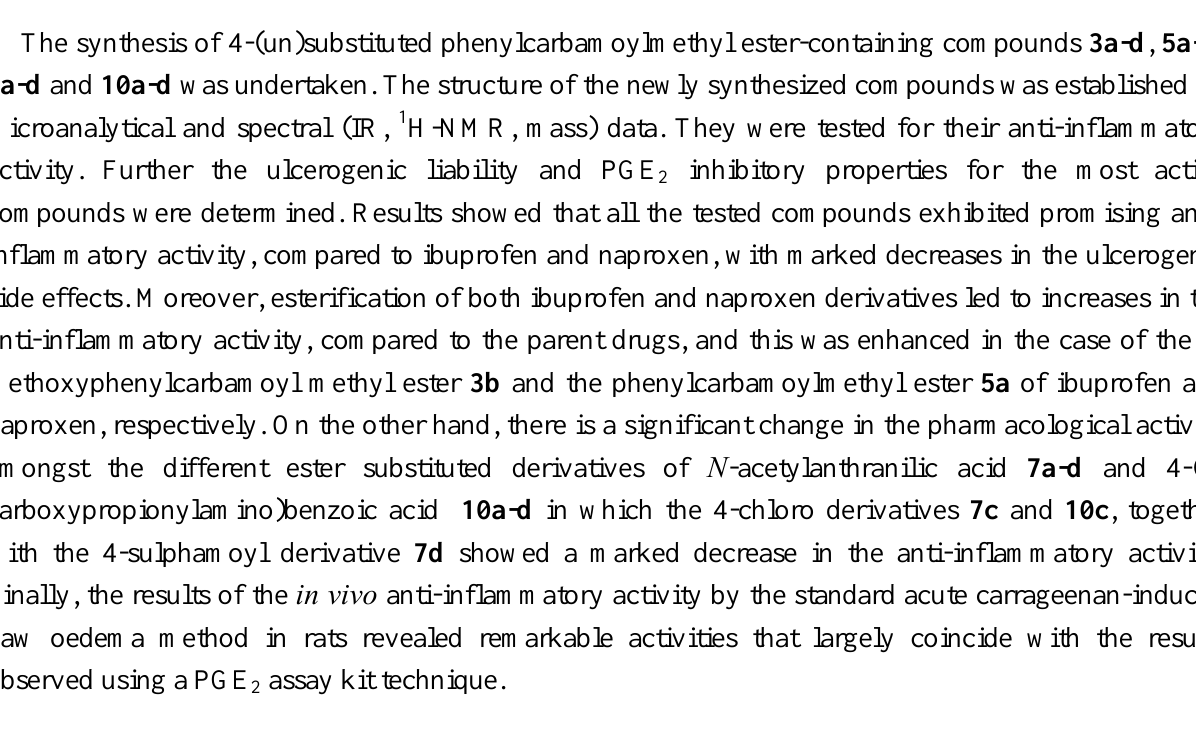
Results are means of 6 experiments ±